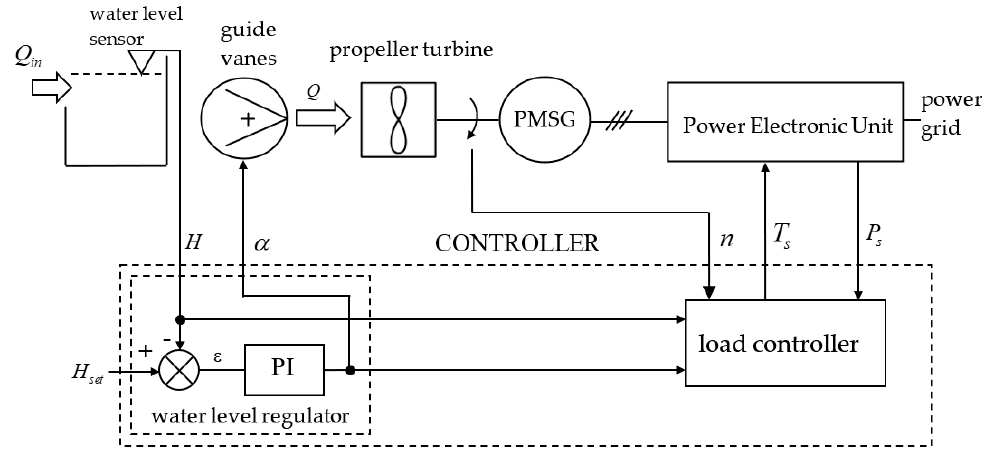
Figure 6. Algorithm for controlling a single hydro-set.